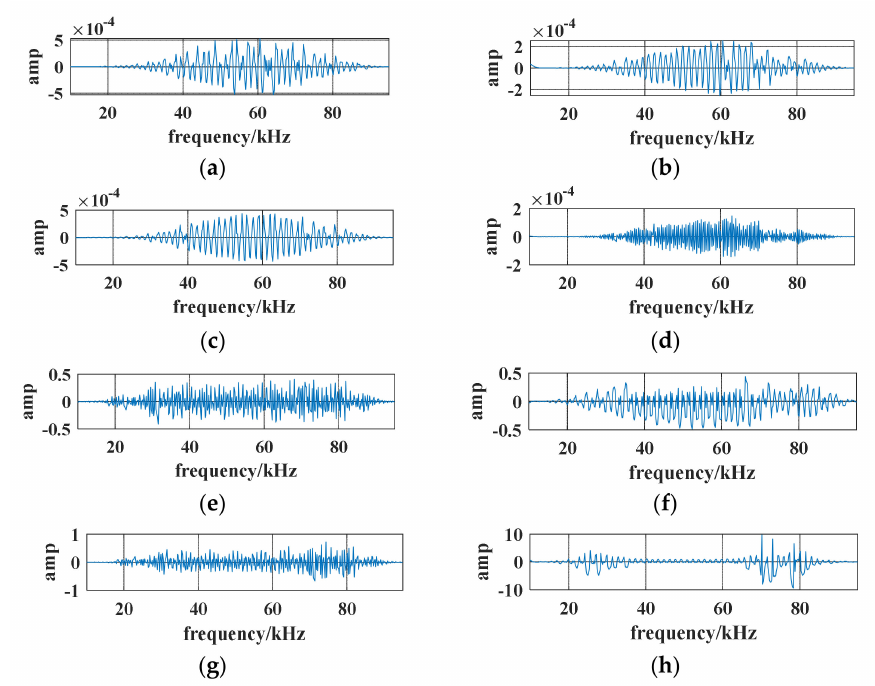
Figure 8. The fluctuation amplitude–frequency curve after removing the mean curve: ( a ) M-side spectrum current fluctuation curve in an internal fault; ( b ) M-side spectrum current fluctuation curve in an external fault; ( c ) N-side spectrum current fluctuation curve in an internal fault; ( d ) N-side spectrum current fluctuation curve in an external fault; ( e ) I M / I N current ratio fluctuation curve in an internal fault; ( f ) I M / I N current ratio fluctuation curve in an external fault; ( g ) I N / I M current ratio fluctuation curve in an internal fault; ( h ) I N / I M current ratio fluctuation curve in an external